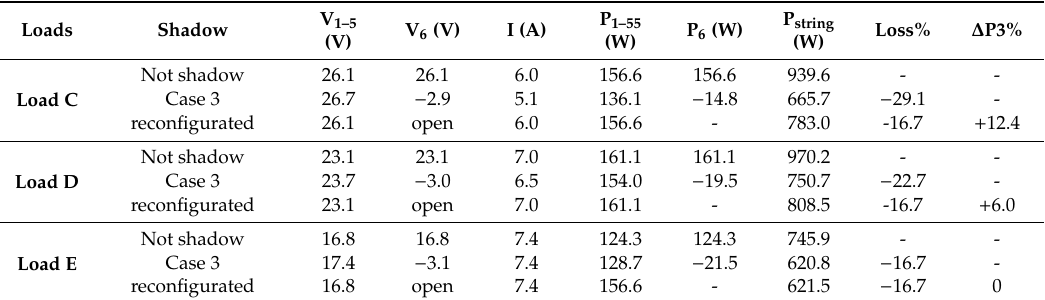
Table 12. Characteristics in different load conditions evaluated by reconfigurator for each panel.